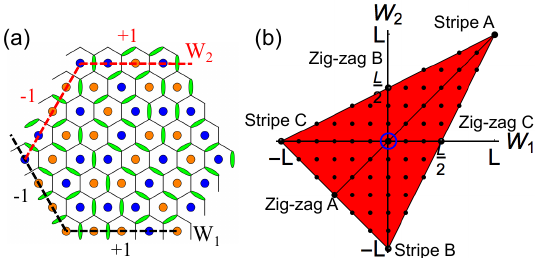
Figure 15: Winding numbers sectors of the triangular-lattice Ising antiferromagnet (reproduced from Ref. [ 11 ] ). (a) A pair of reference lines is defined on hexagonal clusters with periodic boundary conditions, and the dimer crossing of these lines gives the winding number W = ( W crossing the horizontal lines increase W This is simply related to the number of strings crossing the reference lines by Eq. 30. (b) The allowed winding number sectors for an L = 12 cluster are shown by black dots. W lie within a triangle with vertices at W = ( L , L ) , W = ( − L ,0 ) and W = ( 0, − L )